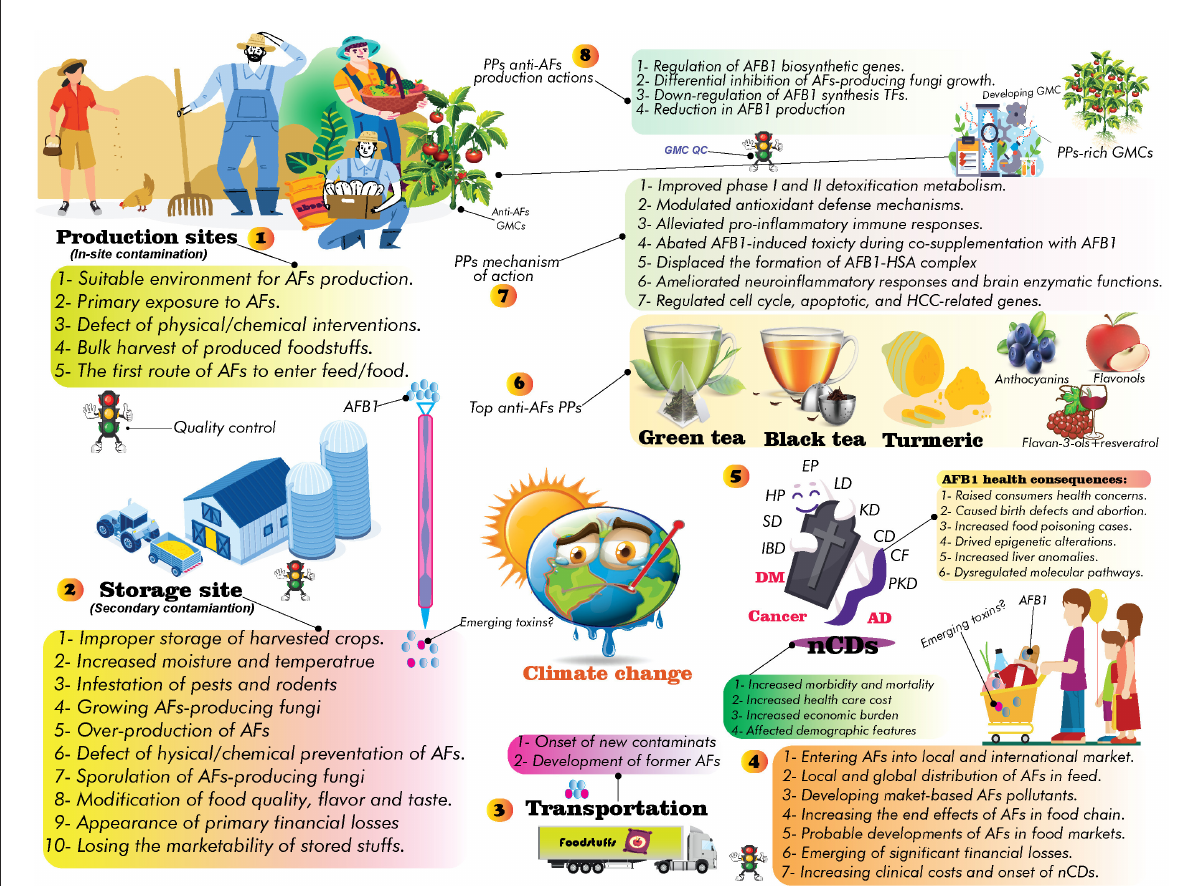
FIGURE12 The findings of this study at a quick glance. AFs in production/storage sites caused damage to target products and passed to consumers, leading to the progression of nCDs (Steps 1–5). Certain classes of PPs alleviated the side effects of AFs by modulating several critical signaling pathways involved in the pathogenesis of AFs. Indeed, these compounds could inhibit the formation of AFs by regulating expression of critical genes involved in biosynthetic pathways of AFs (Steps 6–8). Climate change markedly affects the occurrence of AFs, therefore, developing